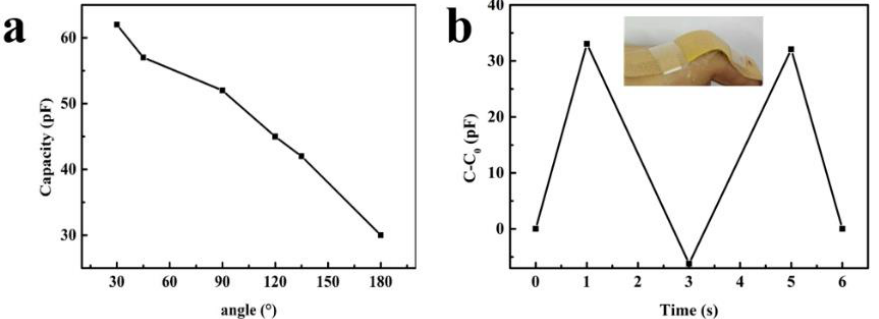
Figure 8. ( a ) The bending angle related capacitance of flexible sensor; ( b ) The capacitance change C-C 0 response to repeating finger bending. Inset is the flexible pressure sensor integrated on a bandage to detect the finger bending.